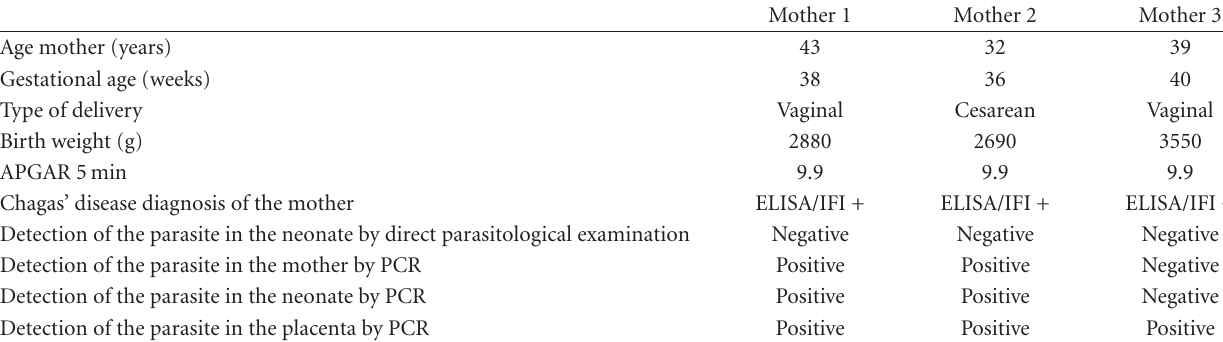
Table 1: Characterization of clinical features of mothers and